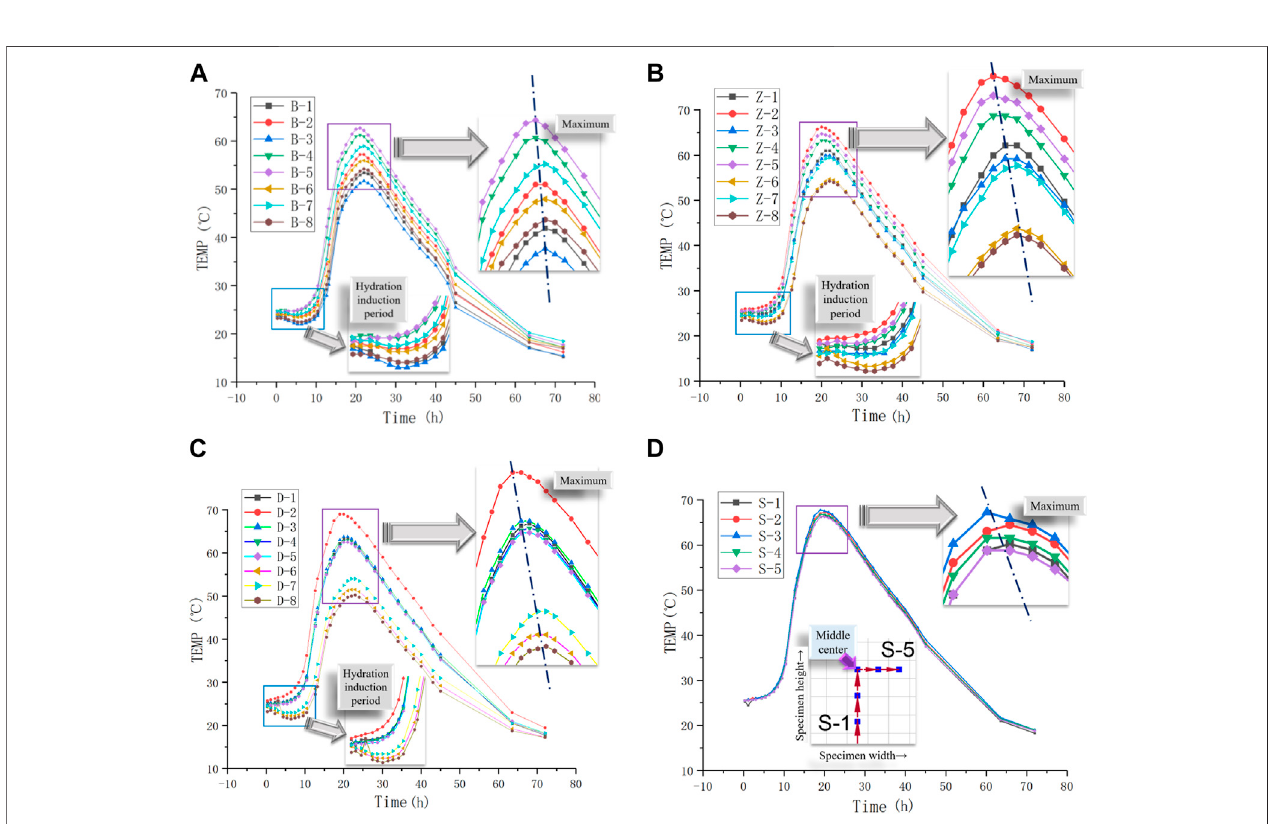
FIGURE 8 | Temperature of concrete measurement point in each test section. (A) Surface layer temperature evolution. (B) Mid-layer temperature evolution. (C) Bottom layer temperature evolution. (D) Vertical temperature measurement.